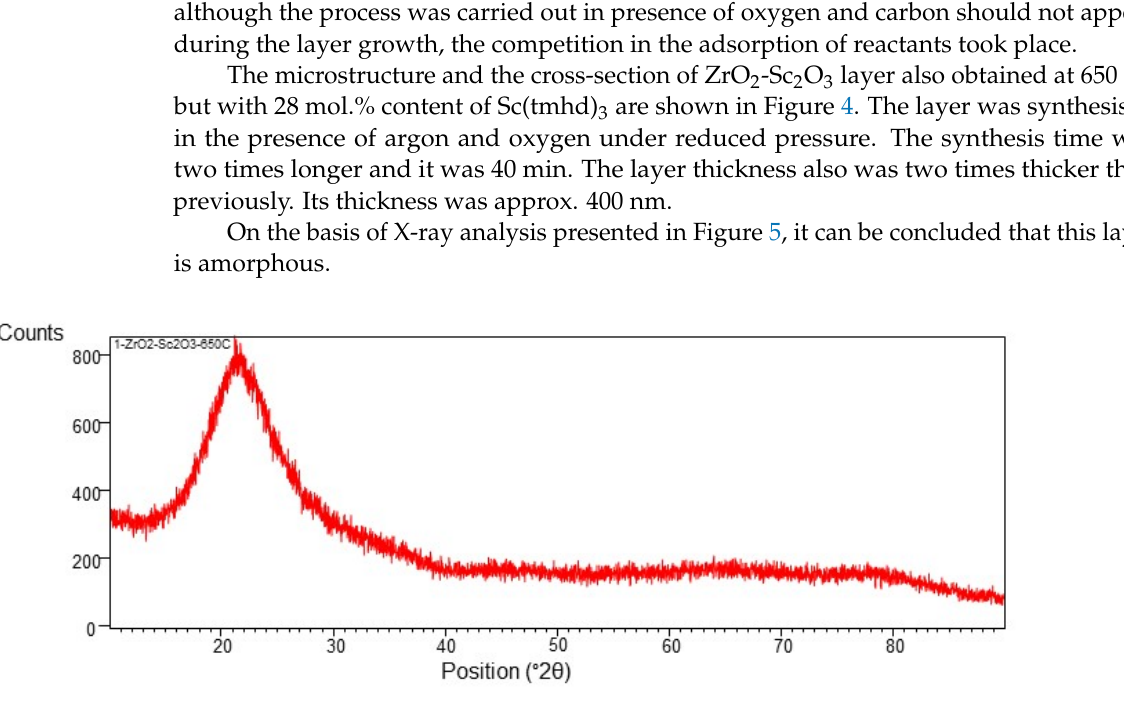
Figure 5. X-ray diffractogram of the layer deposited at 650 °C (demonstrated in Figure 4). Results of EDS analysis indicate that the molar content of Sc 2 O 3 in the layer was 14.09% (Table 4) which means that the value obtained is consistent with the expected value. Table 4. Average chemical composition determined by EDS analysis and calculated molar content of Sc 2 O 3 in the layer (Figure 4). The synthesis temperature: 650 °C. Total gas pressure: 6580 Pa. The molar content of Sc(tmhd) 3 in the gas mixture: 28%.